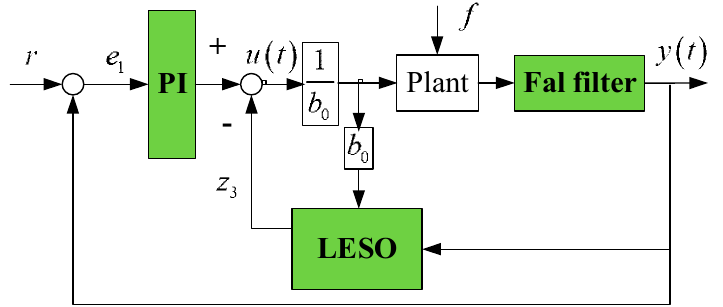
Figure 8. Block diagram of improved ADRC.